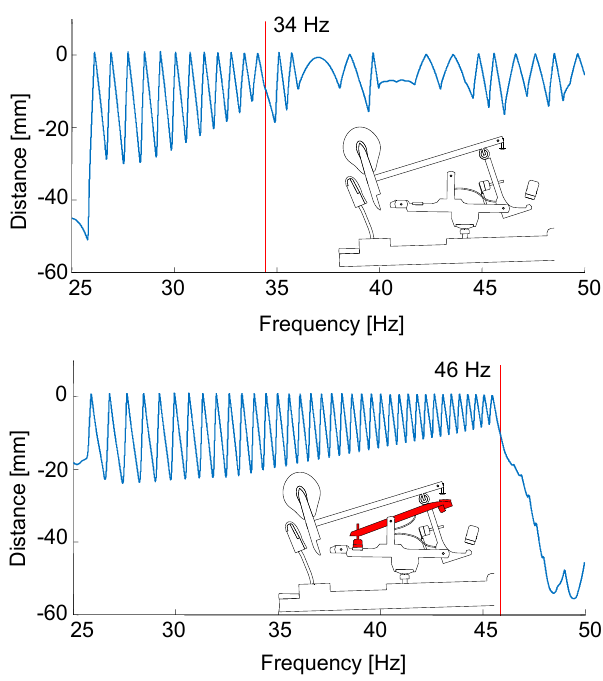
Figure 24. Single (top) versus double escapement (bottom) com-